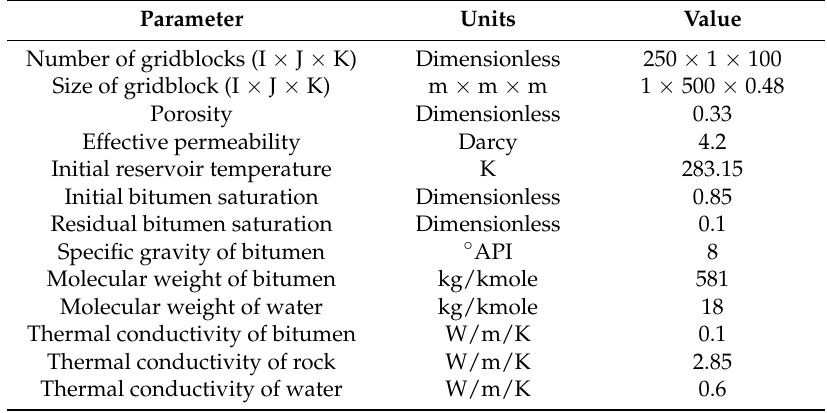
Figure 5. Configuration of a reservoir model inspired by the McMurray formation in Athabasca oil sands, Canada. Table 1. Reservoir properties used for optimizing the ES-SAGD process.